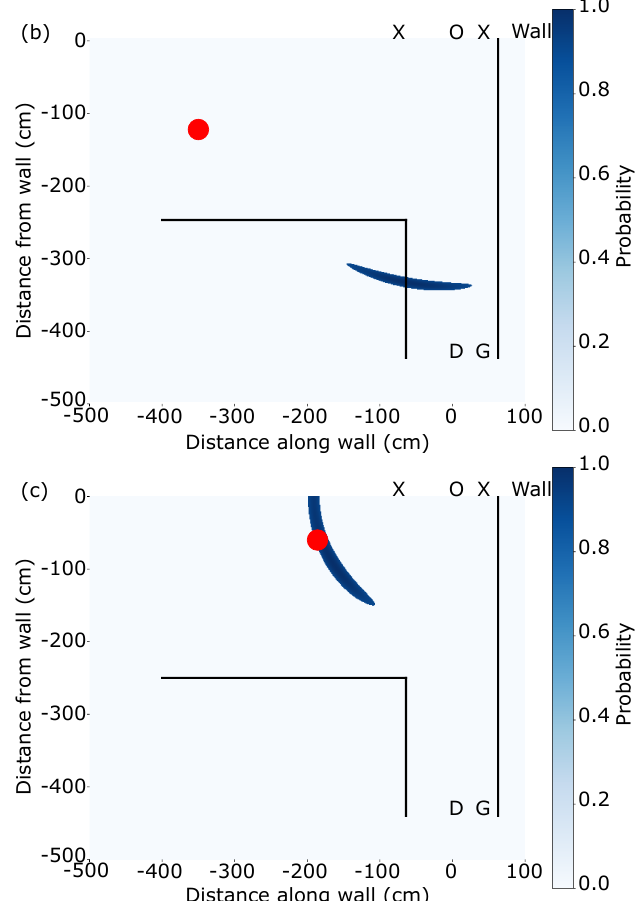
Figure 3. Highest probability position ( > 90%, blue) for three target positions in ( a – c ) (target position in the three figures is shown as a red circle) showing that the system can locate a hidden target up to around 2.5m around a corner. Black lines denote walls, D is the APD position, G is the scanning galvanometer mirror position, O is the observation point and the Xs show the laser spot positions